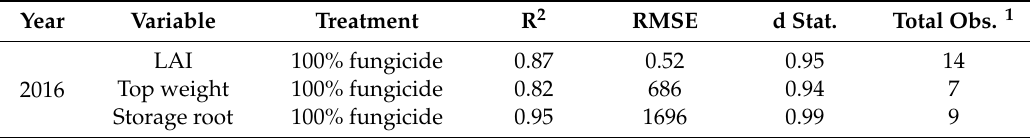
Table4. DetailedstatisticsforsimulatedandobservedvaluesofLAI(m 2 m − 2 ),topweight(DM) kg ha − 1 ,